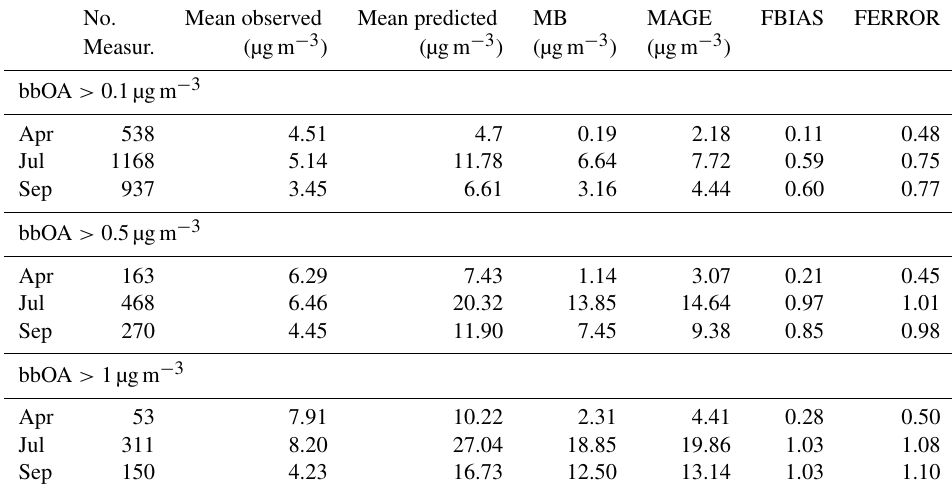
Table 2. PMCAMx-SR alternative scheme OA prediction skill metrics against observed values from CSN and IMPROVE networks at biomass-impacted sites. No. Mean observed Mean predicted MB MAGE FBIAS FERROR Measur. (µgm − 3 ) (µgm − 3 ) (µgm − 3 ) (µgm − 3 ) bbOA > 0.1µgm − 3 Apr